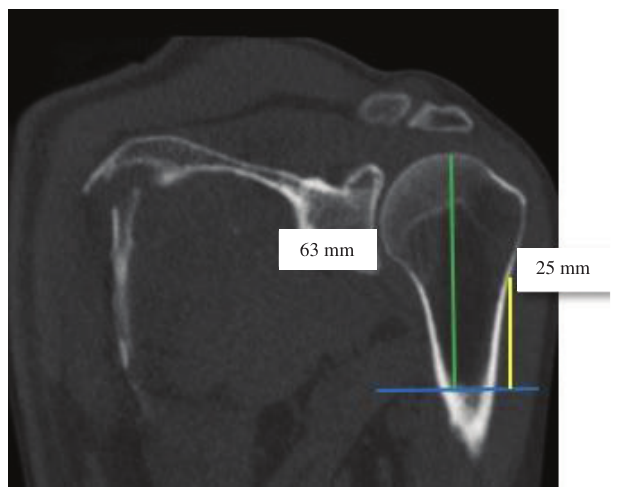
Figure 11. PM-greater tubercle distance (green) was almost equal to PM-anatomical neck distance (yellow) (ratio = 0.6).